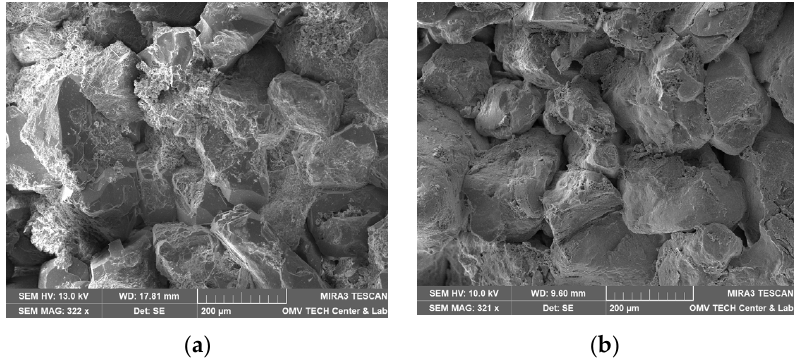
Figure 1. Scanning electron microscope (SEM) image measured for the core material used in this work; Berea is shown in ( a ) and Keuper in ( b ). In ( a ), quartz cement can be identified by its smooth surfaces compared to the sand grains. Kaolinite is placed between sand grains in its typical book shape. In ( b ), the sand grains are more rounded compared to Berea ( a ), but a reduced amount of clay and quartz cement is visible.